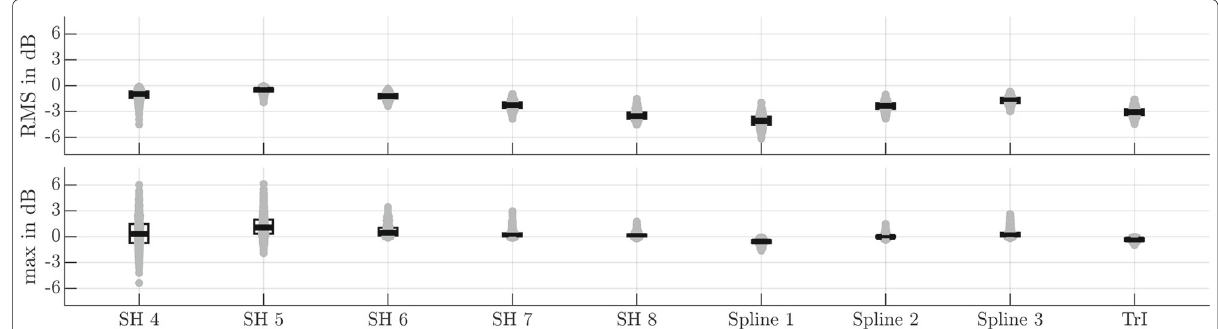
Fig. 2 Distribution of the relative changes in root mean square (RMS) in dB (top) and maximum values (bottom) when interpolating Gaussian input noise with the SH, spline, and triangular interpolation methods, for 1000 independent instances of a random input vector f . On each box, the center indicates the median, and the bottom and top edge of the box show the 25th and 75th percentiles,